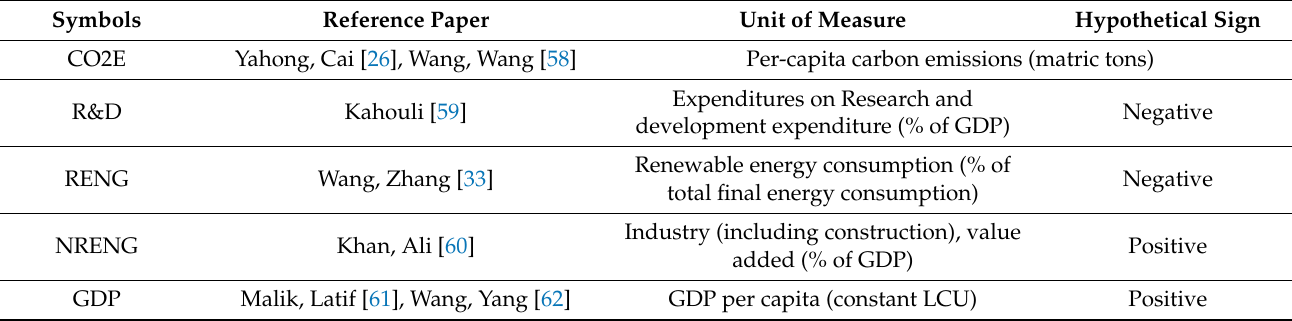
Table 2. Details of the